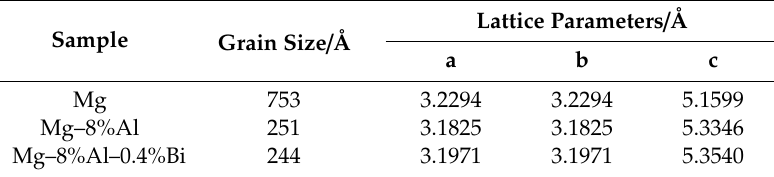
Table 2. Grain size and lattice parameters of the Mg–Al–Bi alloys.